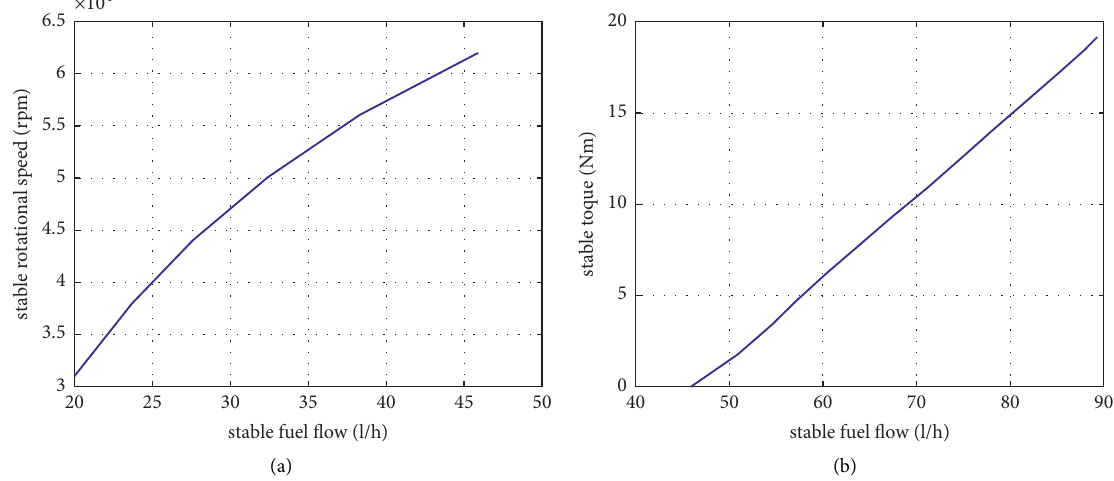
Figure 5: Steady-state data relationship. (a) Stable fuel flow vs stable speed. (b) Stable fuel flow vs stable torque.